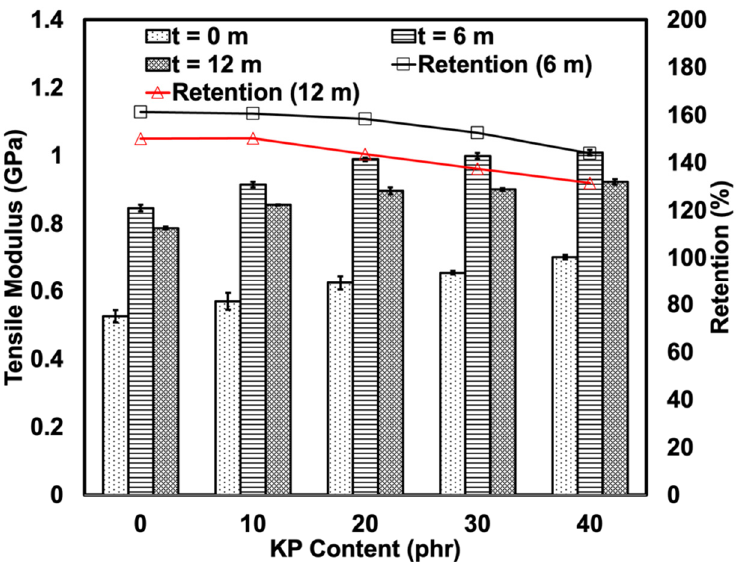
Figure 8. Tensile modulus and retention of KP-filled rHDPE/NR blends before and after 6 and 12 months of natural weathering.